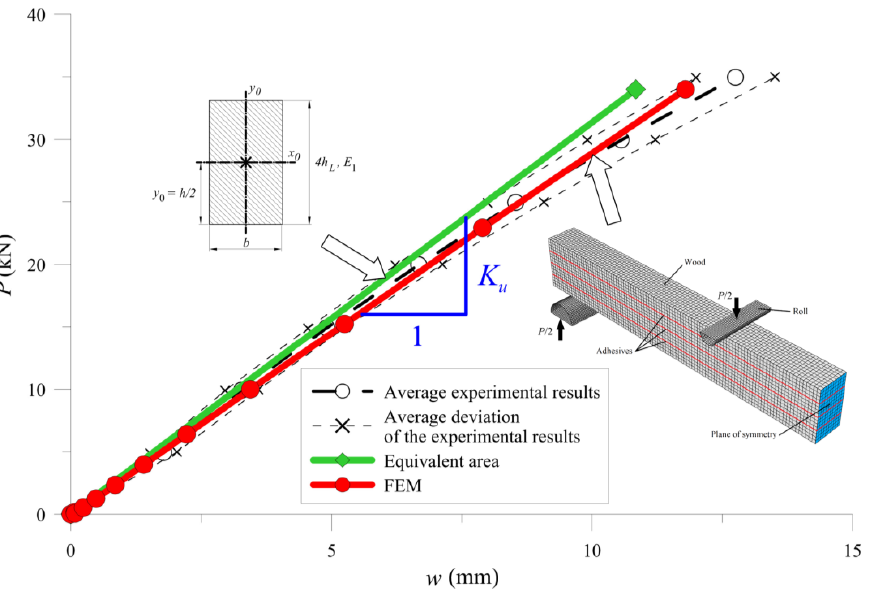
Figure 24. FE models for B, BW and BWW beams.